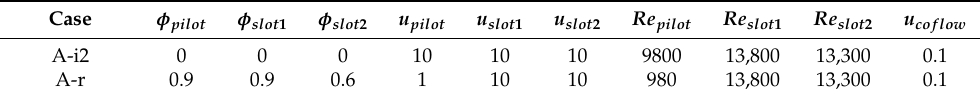
Table 1. Flow parameters of the two investigated